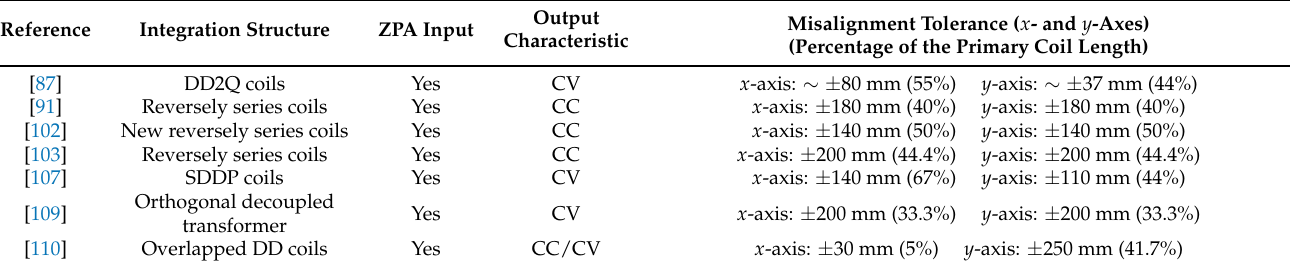
Table 5. Summary of the single-sided integration